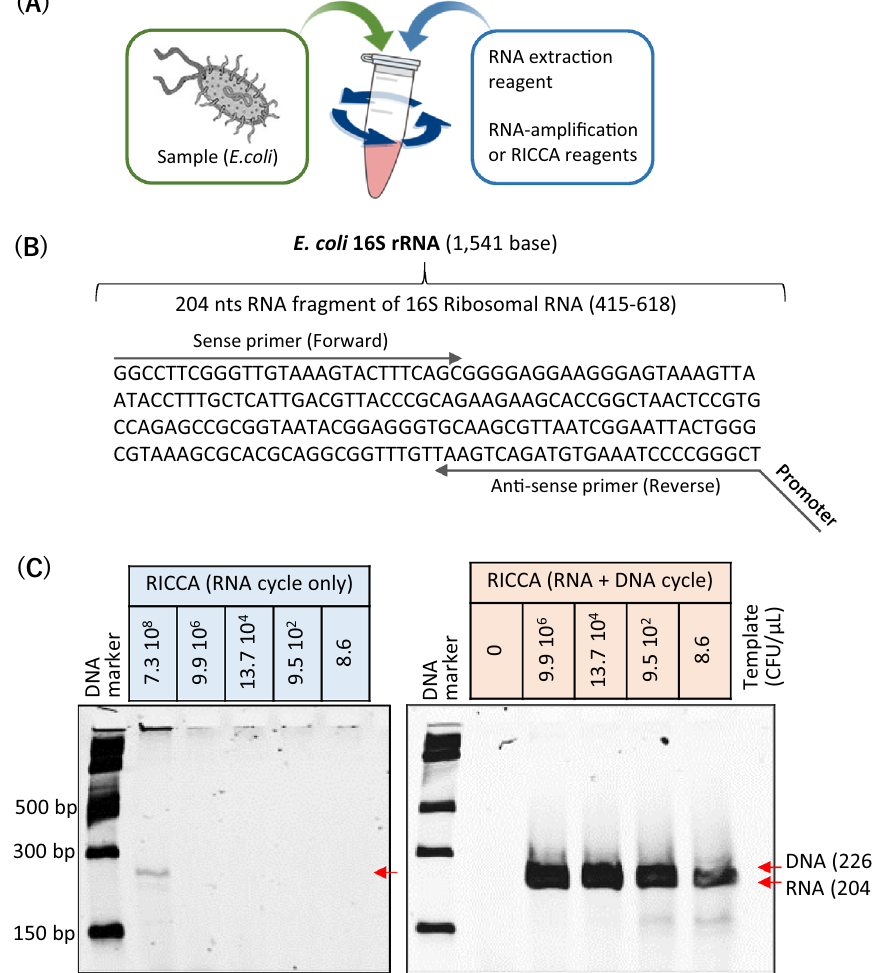
Figure 2. Demonstration of one-pot RICCA for field application. ( A ) Schematic view of the one-pot reaction protocol for RNA extraction to RNA/DNA amplification. ( B ) Target sequence of the E. coli genome for amplification. The sequence to which primers bind is indicated by arrows. ( C ) Electrophoretic analysis for comparatively evaluating the detection limits of RNA-specific amplification without (left) and with (right) DNA-specific amplification. E. coli cells at levels ranging from 10 9 to 10 1 were mixed with saliva (5% v/v) and used directly as the template for RNA extraction followed by RNA or DNA amplification. The desired amplified product (204-nt RNA or 226-bp DNA) is indicated by red